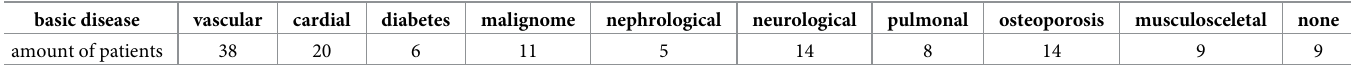
Table 2. Basic disease of the patients divided in vascular, cardial disease, diabetes, malignome, nephroplogical, neurological and pulmonal disease, osteoporosis, musculosceletal disease and no basic disease. basic disease vascular amount of